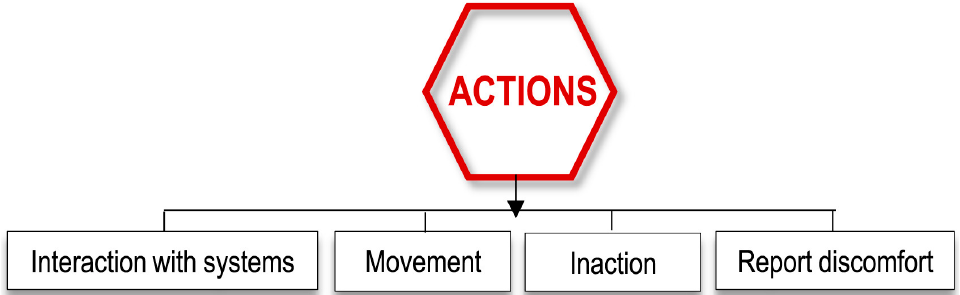
Figure 14. Actions taken by occupants to cover their needs [112] (Reprinted from Elsevier Building and Environment, Volume 92, Tianzhen Hong, Simona D’Oca, William J.N. Turner, Sarah C. Tay ‐